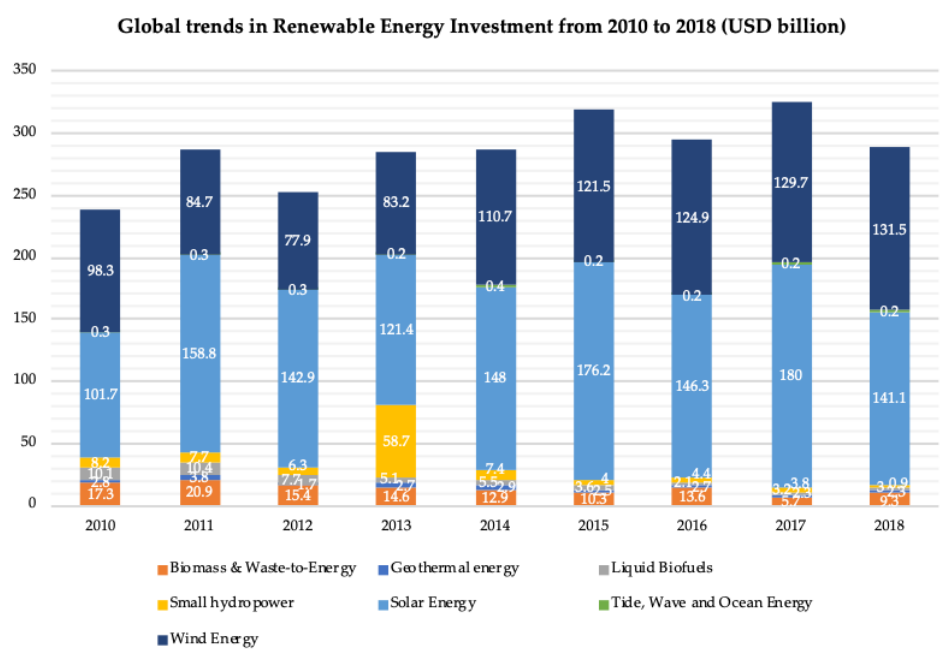
Figure 14. Global trends in Renewable Energy Investment from 2010 to 2018 (Source: IRENA).